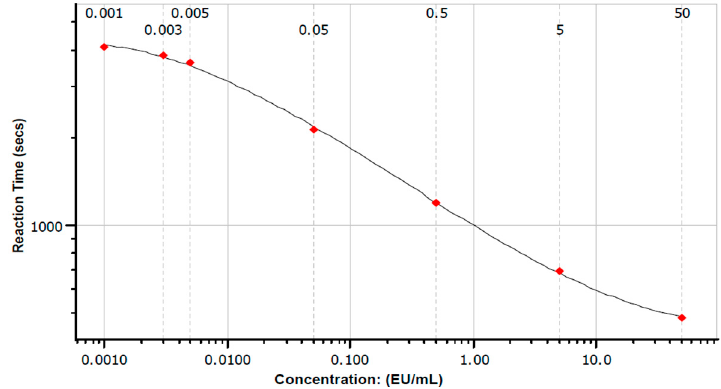
Figure 1. Polynomial model of reaction time vs. endotoxin concentration. Figure shows polynomial standard curve fit: For the fitted log-log linear model r = − 0.996, slope = − 0.214, y intercept = 3.026, coefficient of variation (CV%) = 2.02%.